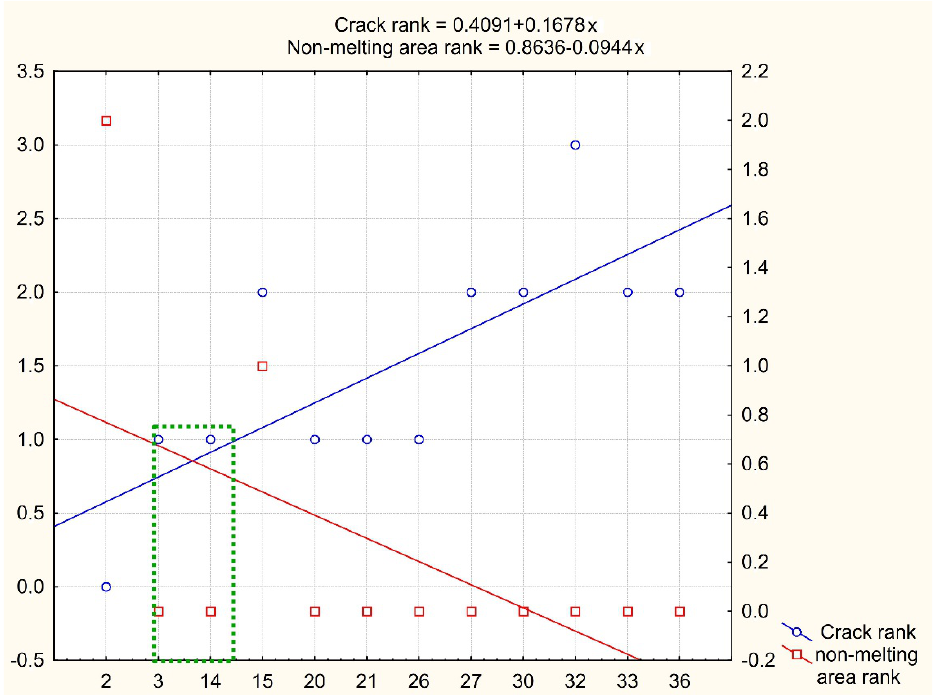
Figure 4. RSA Method for Determining the Area of Optimal Fe-6.5Si Alloying Modes.